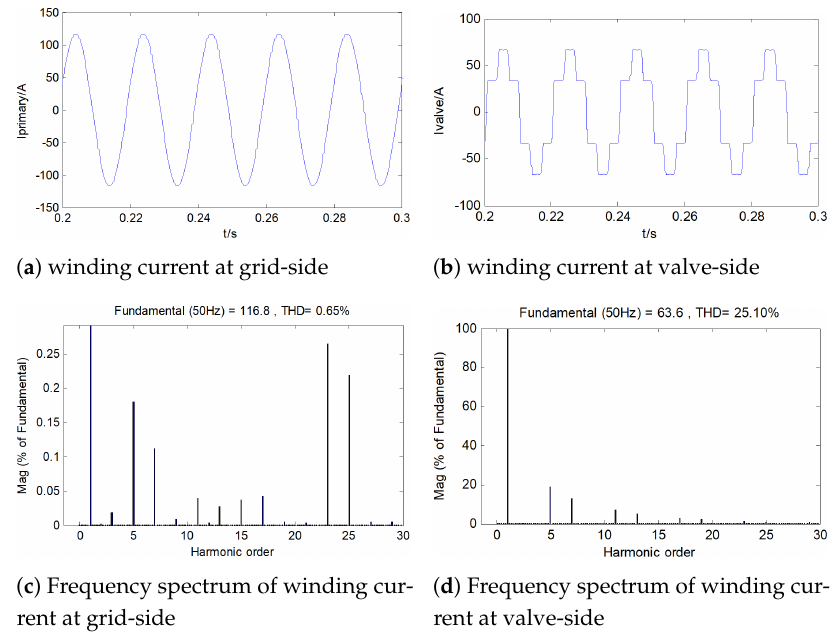
Figure 11. Waveform and frequency spectrum of the winding current from the valve-side and grid-side on the right column of the converter transformer under working condition